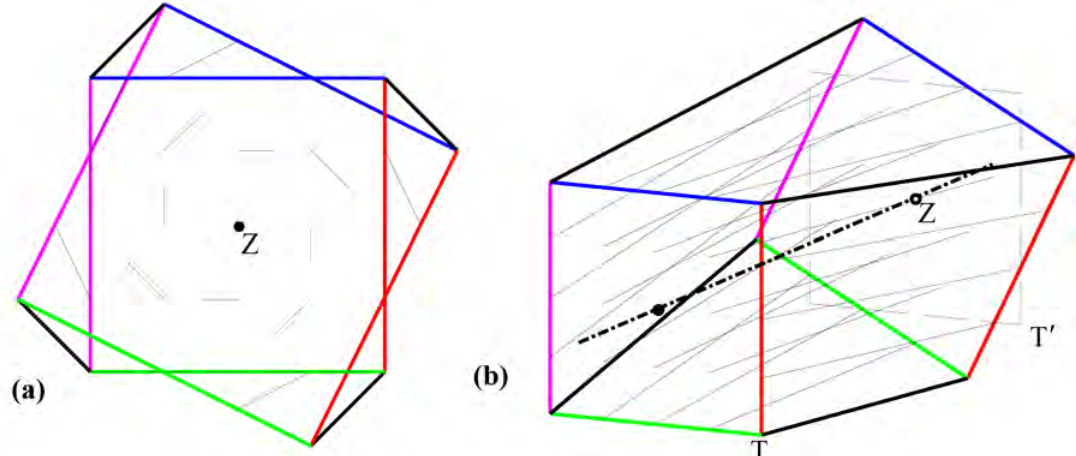
Figure 2 A pencil of divergency 4/ LM = D at entrance plane T. There are no principal meridional planes and no foci. (a) shows the view along longitudinal axis Z from a point upstream of the entrance plane. (b) azimuth °− 64 64 °− 64 , elevation 12 °− 64 .